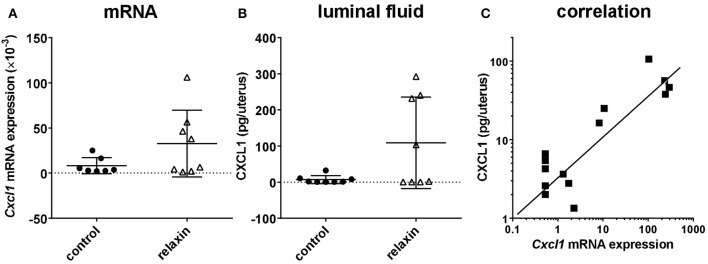
Effect of recombinant human relaxin (rhRLN) injected into the uterine horns at estrus on uterine Cxcl1 mRNA expression assessed by qRT-PCR (A), and CXCL1 secretion into uterine luminal fluid assessed by specific ELISA (B), and the correlation between these parameters for individual mice (C). Data are mean ± SEM (n = 7–8 per category). In panel (C), symbols indicate data from mice both receiving or not rhRLN.